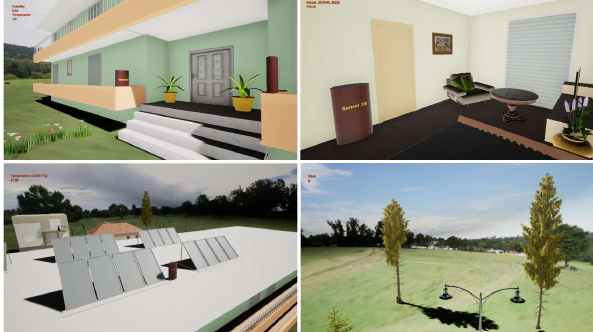
Figure 8. The selected model form to represent the sensors and their placement towards the indoor and outdoor virtual environment